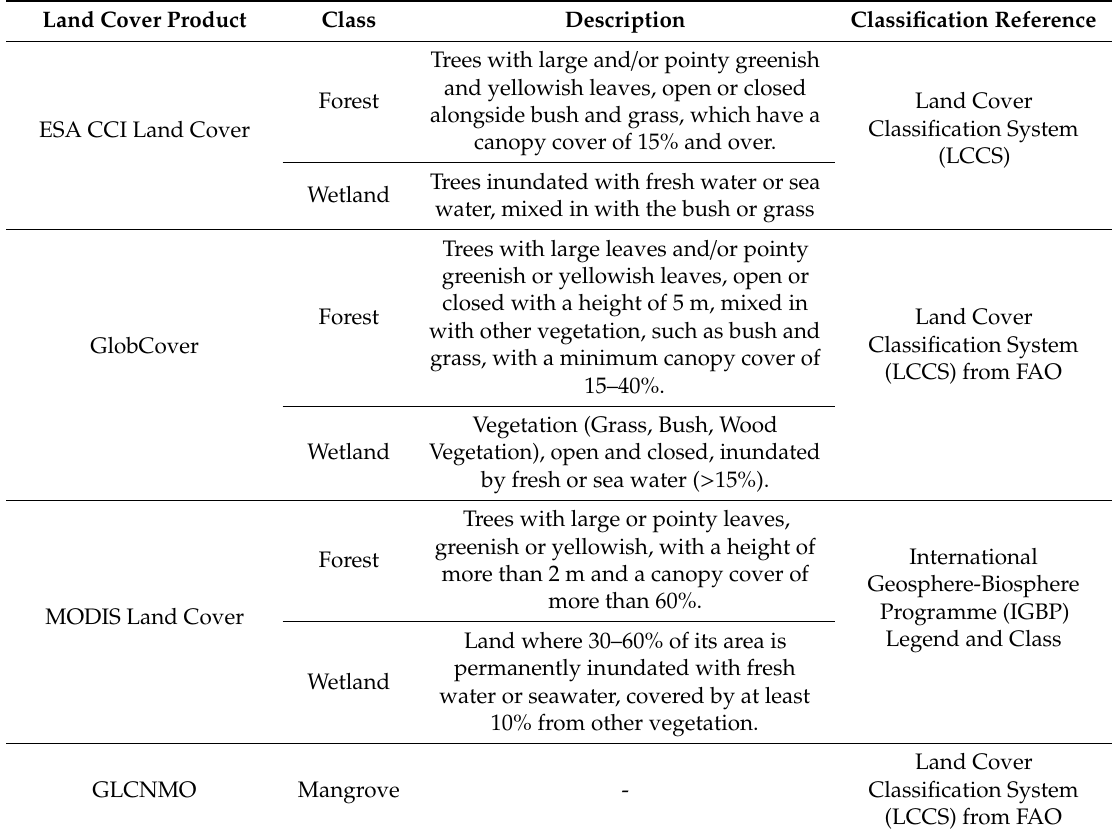
Table 4. Classes of each land cover product defined in the “mangrove forest”